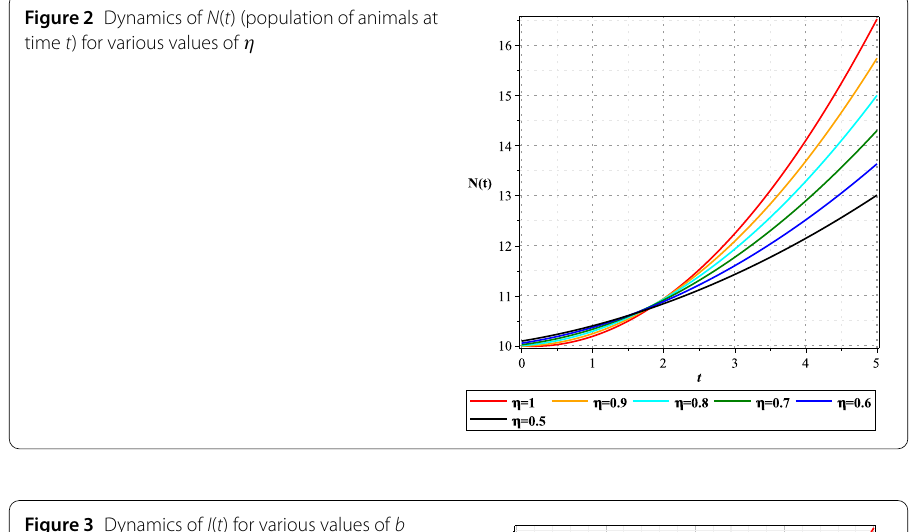
Figure 2 Dynamics of N ( t ) (population of animals at time t ) for various values of η